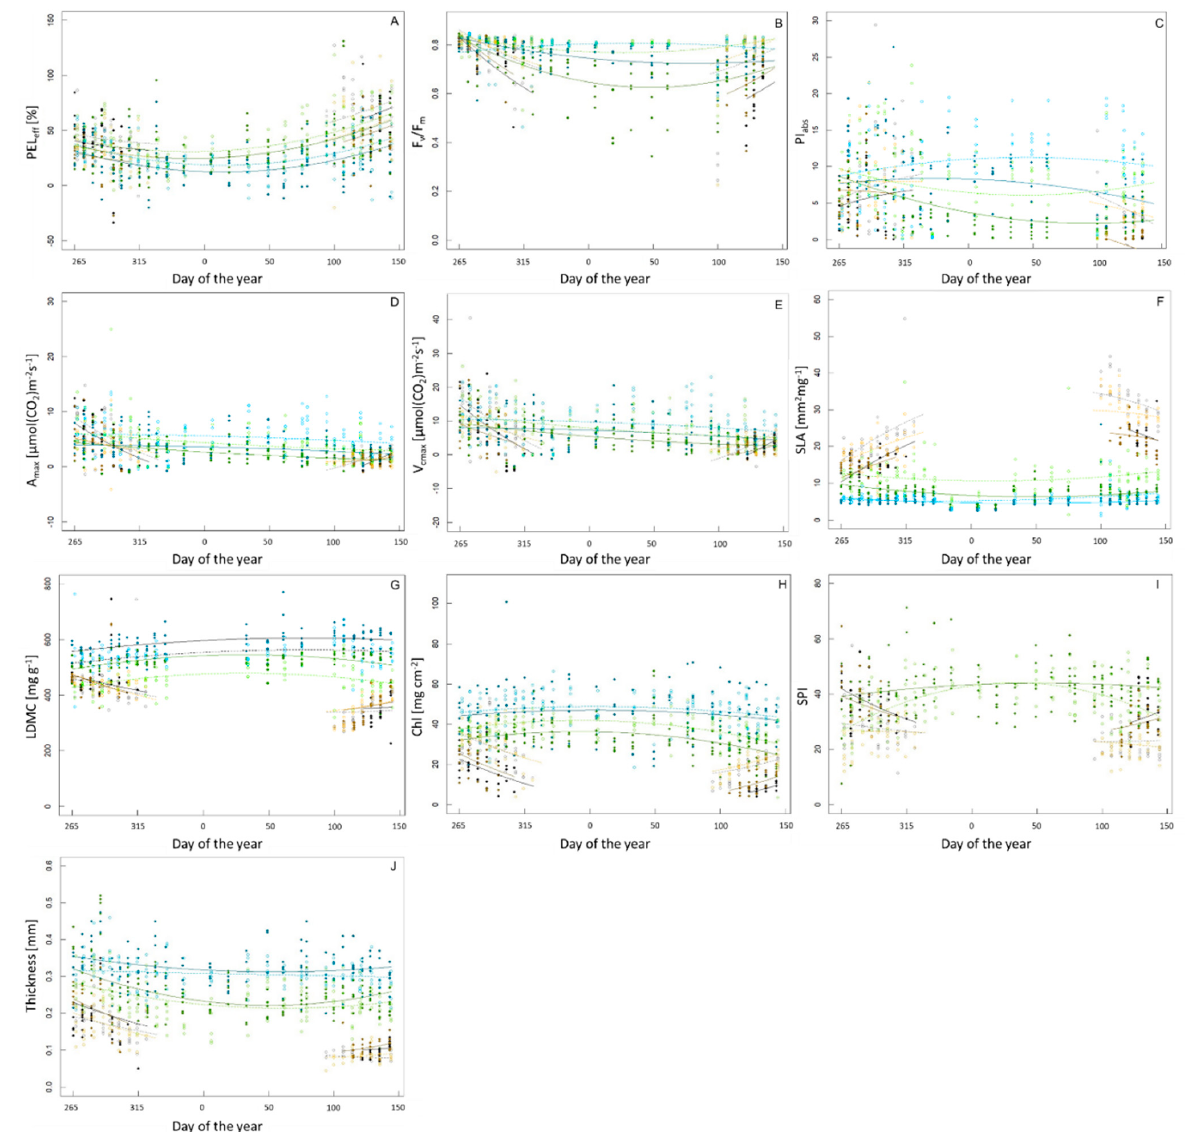
Figure 1. Seasonal variation of parameters recorded, namely ( A ) frost resistance as effective percentage of electrolyte leakage (PEL eff ), ( B ) efficiency of PSII (F v /F m ), ( C ) performance index (PI abs ), ( D ) net CO 2 assimilation rate (A max ), ( E ) maximum carboxylation capacity (V cmax ), ( F ) specific leaf area (SLA), ( G ) leaf dry matter content (LDMC), ( H ) stomatal pore area index (SPI), ( I ) chlorophyll content (Chl) and ( J ) thickness of the leaf. Species are represented by color, the evergreen species Q. ilex is displayed in light blue (inside) and dark blue (outside). Q. rhysophylla was colored in light green (inside) and dark green (outside). The deciduous species Q. palustris is shown in light gray (inside) and dark gray (outside) and Q. rubra is displayed in yellow (inside) and brown (outside). Individuals and species situated in the greenhouse are repre- sented by open circles and a dashed line, individuals and species that experienced outside conditions are represented by a diamond and a continuous line. The regression line was based on the minimum adequate models as described in the text .